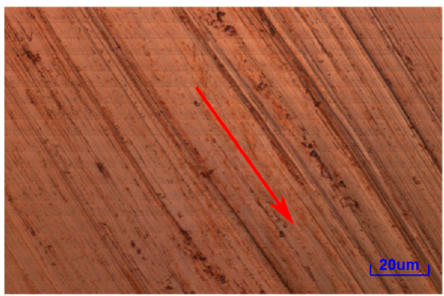
Figure 27. Surface image of the microchannel peak region, which is face ‐ to ‐ face with the mould embossed under the laser energy of 565 mJ. The arrow represents the rolling direction of the copper foil.